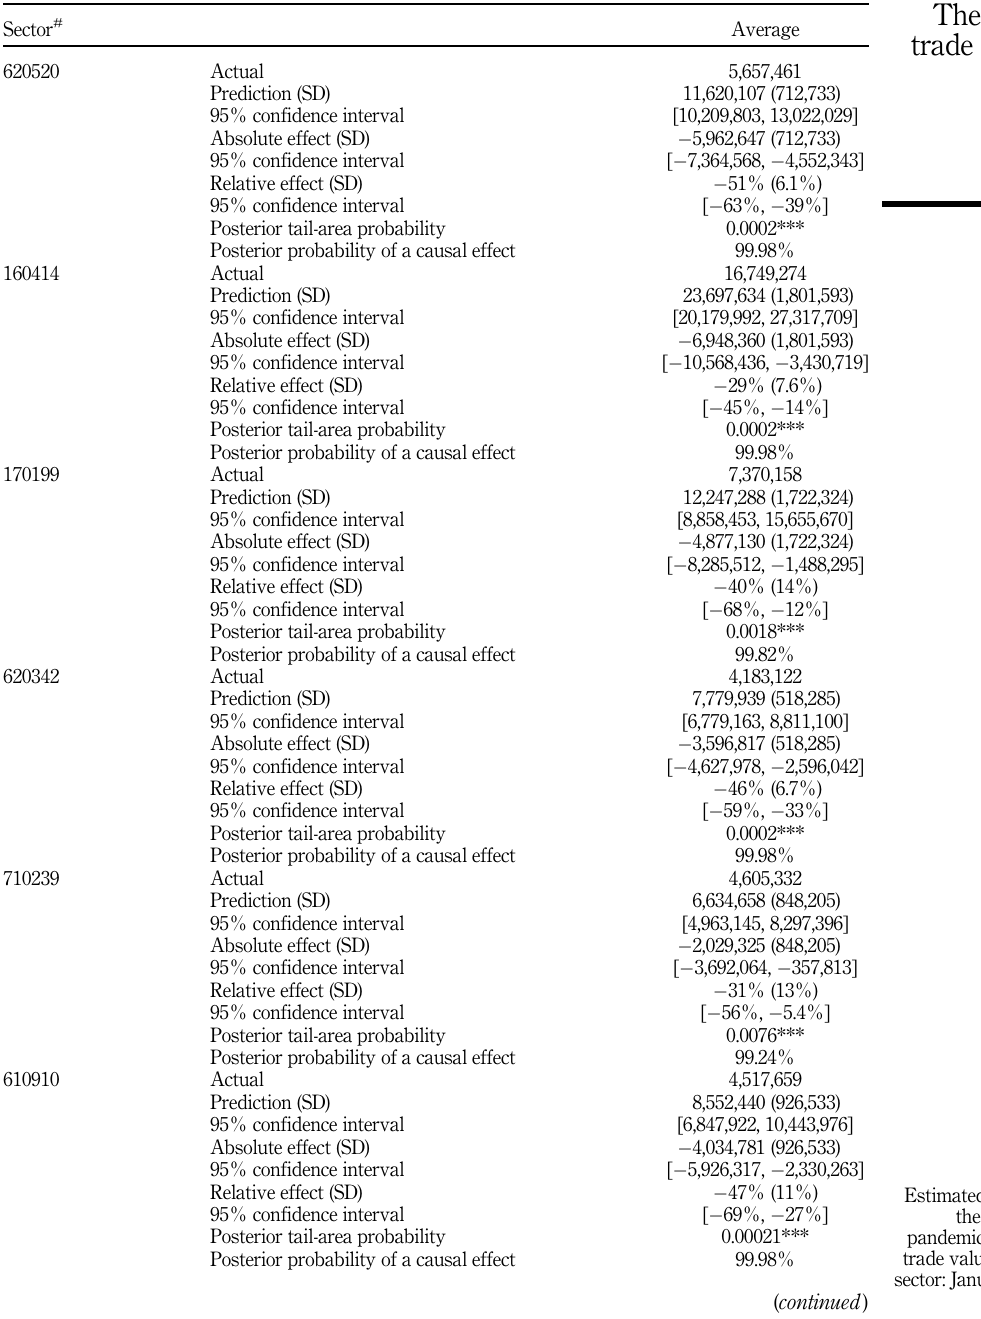
Table 6. Estimated impact of the COVID-19 pandemic on